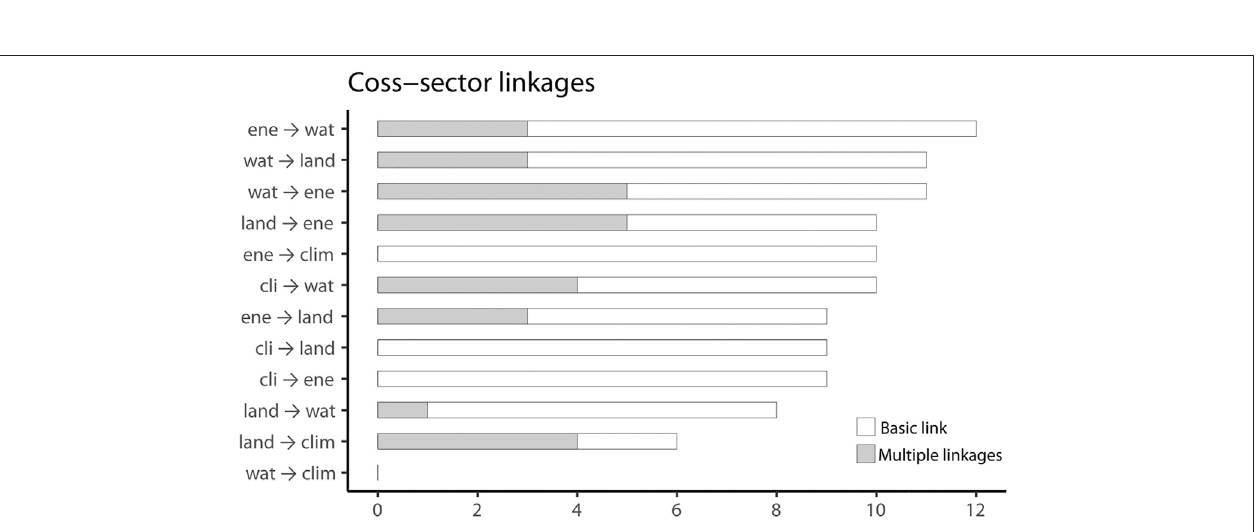
FIGURE 4 | Number of models including interlinkages across sectors with level of detail based on Supplementary Table S3 .